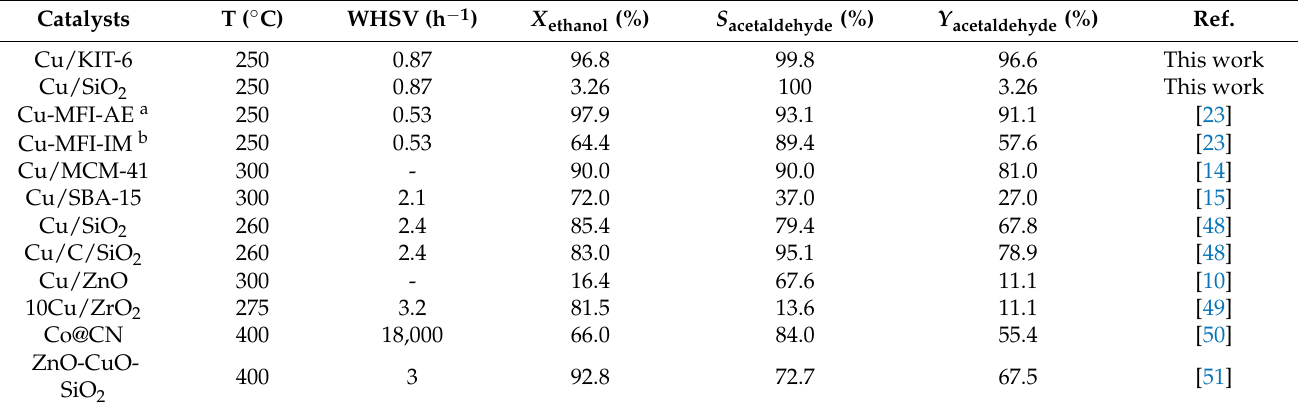
Table 3. A comparative list of the reaction conditions and catalytic activities of ethanol dehydrogena- tion to